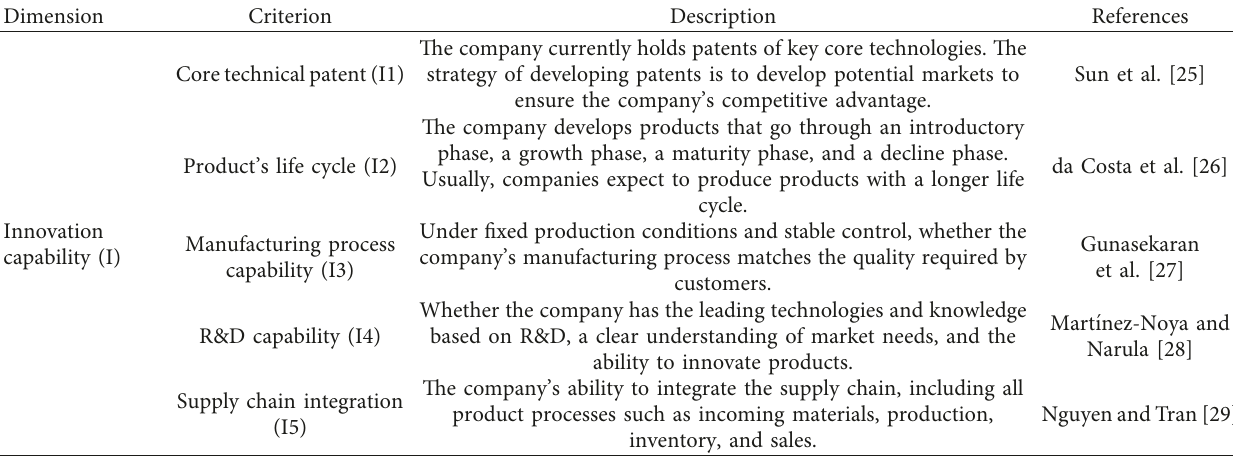
Table 4: The innovation capability dimension and its criteria.